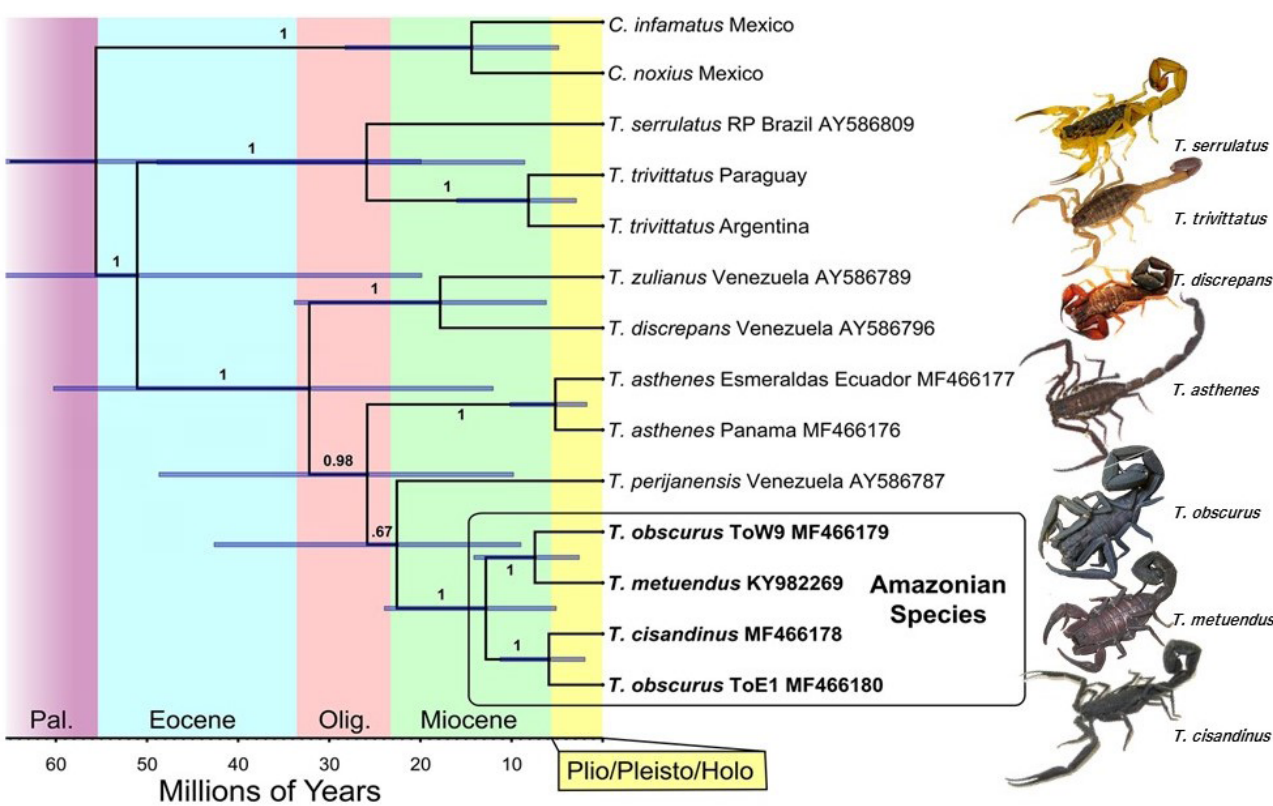
Figure 3. Bayesian chronogram of medically significant Tityus spp. in South America, generated in BEAST. Values at nodes indicate posterior probabilities; bars indicate highest posterior density (HPD) values around mean date estimates. GenBank accession numbers are provided in the tip labels. Centruroides infamatus and C. noxius (Buthidae) were included as an outgroup. Samples of T. obscurus ToW9 and ToE1 come from western and eastern Pará, Brazil,